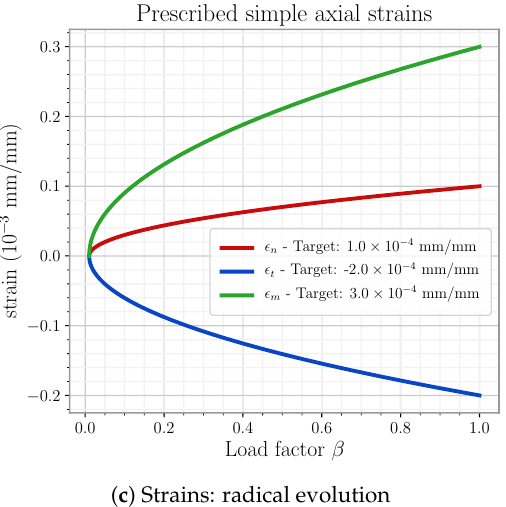
Figure 14. Proposed load evolution through a controlled behaviour of generalised kinematic modes. Part ( a ) prescribes a quadratic evolution for the displacement modes, part ( b ) prescribes an inverse exponential evolution for the rotation modes and in ( c ), a radical evolution is prescribed for simple axial strain